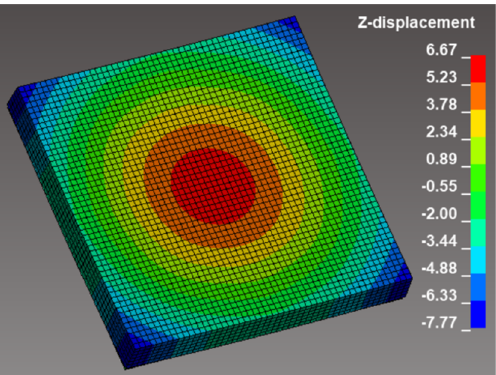
Figure 5. Modelling of the blast load of the concrete slab-displacement (mm) plot of the specimen in 3 ms time instant. 3 ms time instant.